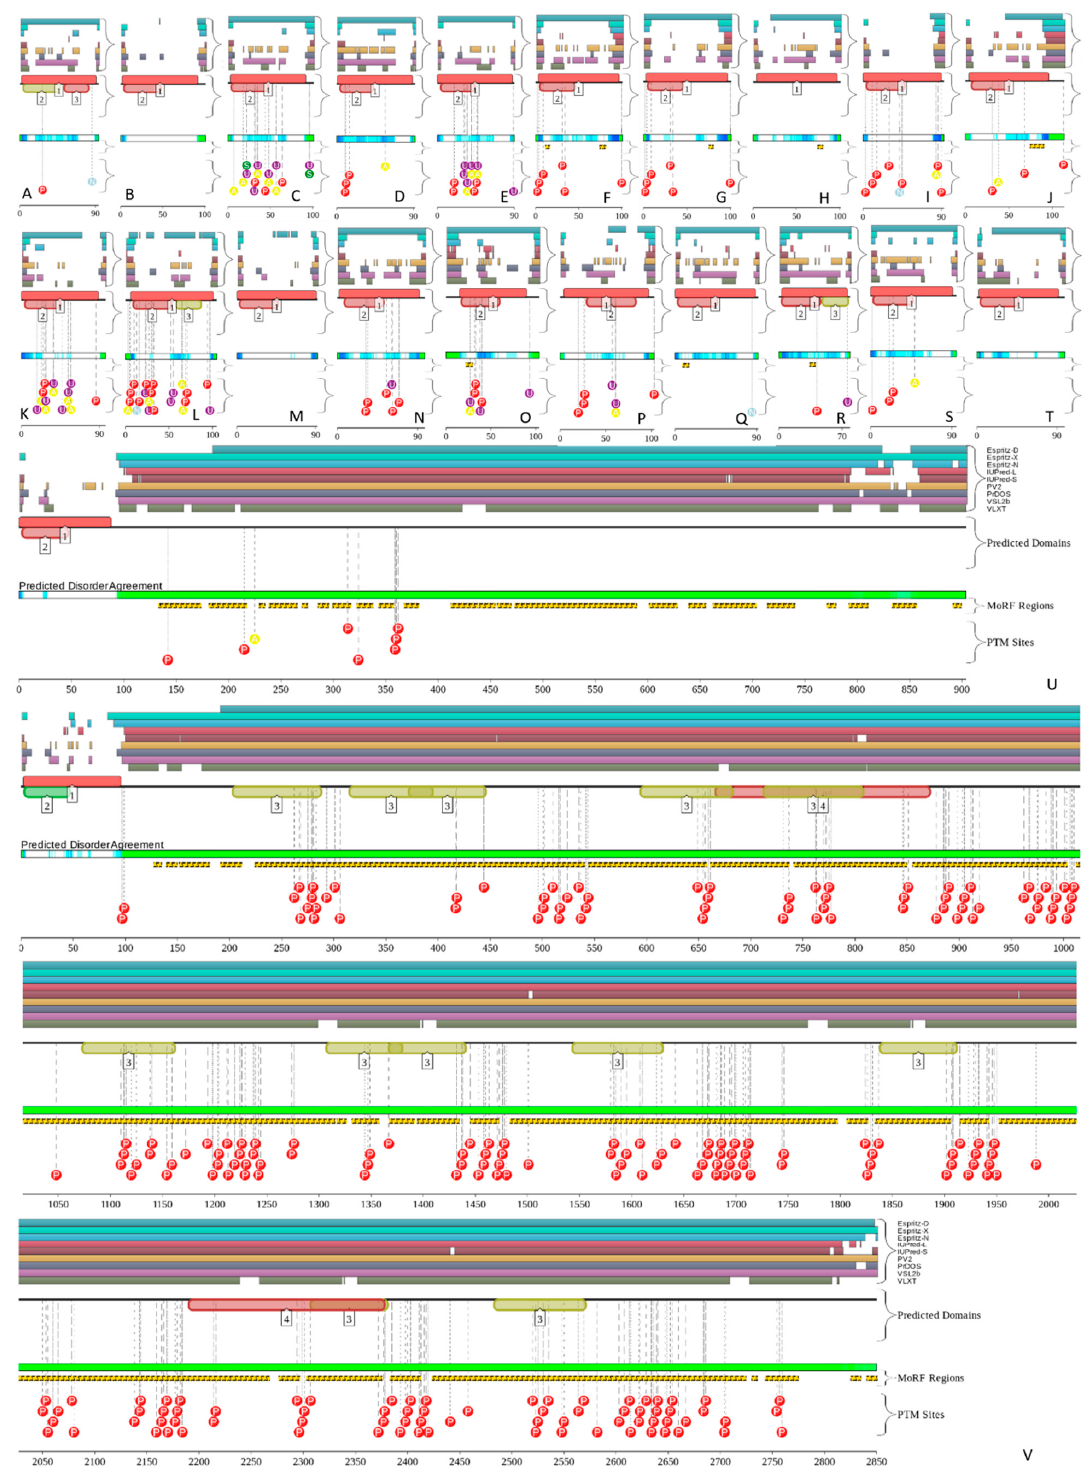
Figure 10. D 2 P 2 -generated functional disorder profiles of human S100 proteins. A . S100A1; B . S100A3; C . S100A4; D . S100A5; E . S100A6; F . S100A7; G . S100A7A; H . S100A7L2; I . S100A8; J . S100A9; K . S100A10; L . S100A11; M . S100A12; N . S100A13; O . S100A14; P . S100A16; Q . S100B; R . S100G; S . S100P; T . S100Z; U . S100A17; V . S100A18. All the keys are described in the legend to Figure 9 .